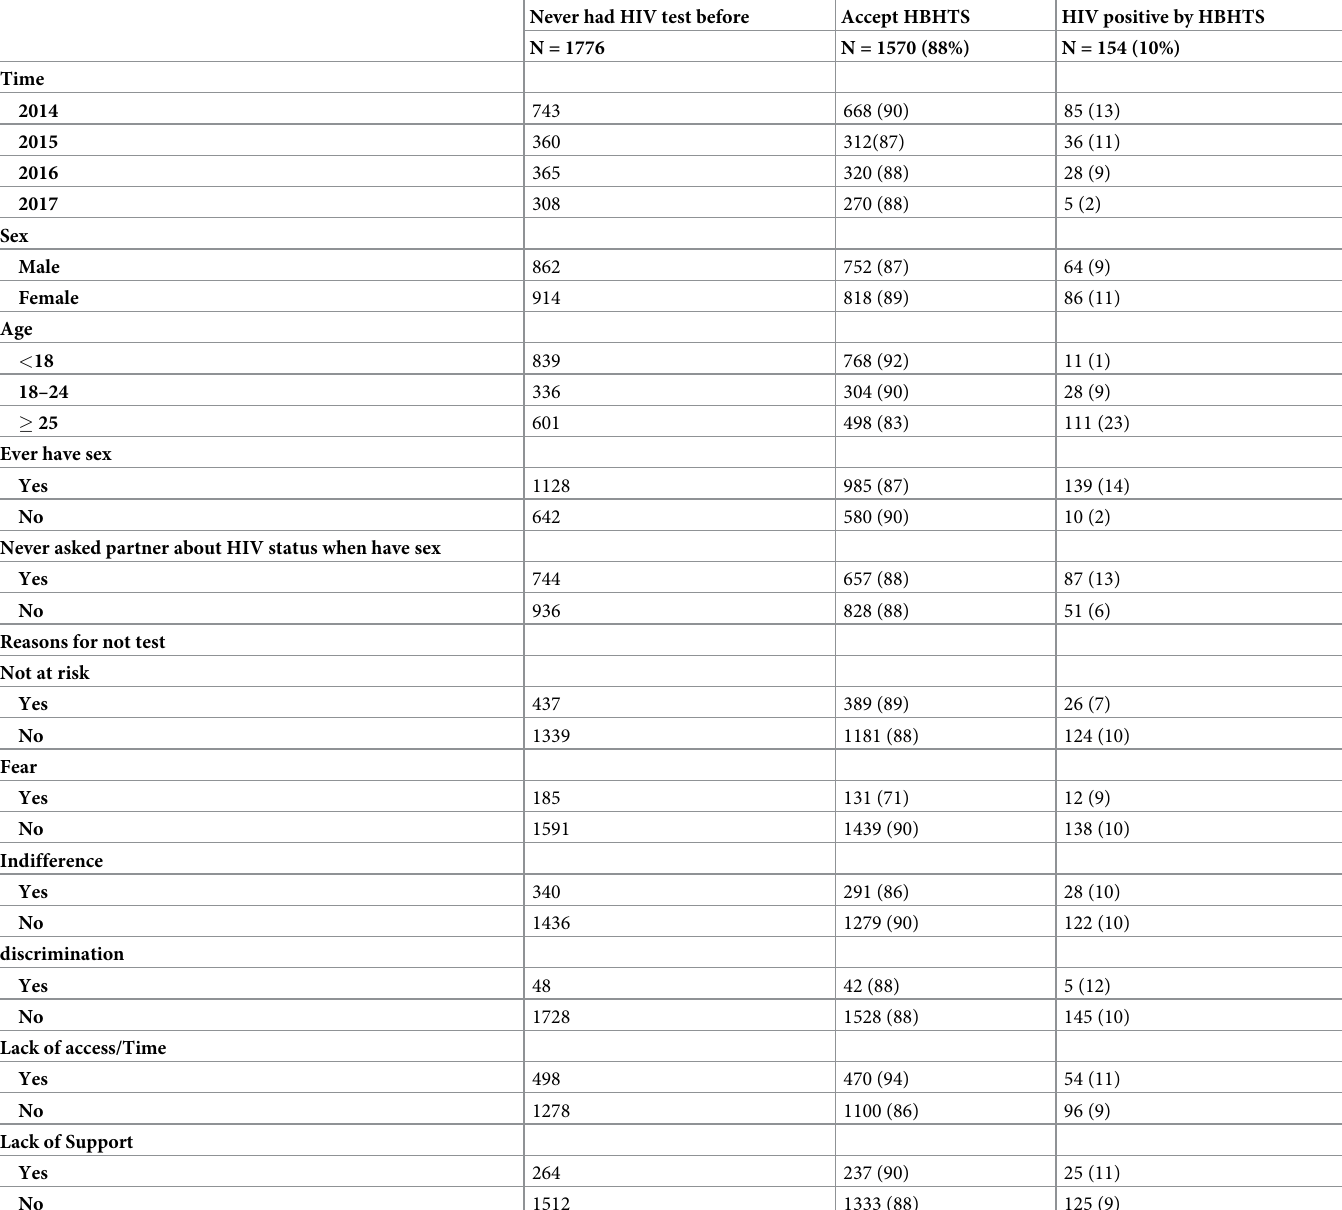
Table 4. HBHTC acceptance and HBHTC positive among persons who have not tested